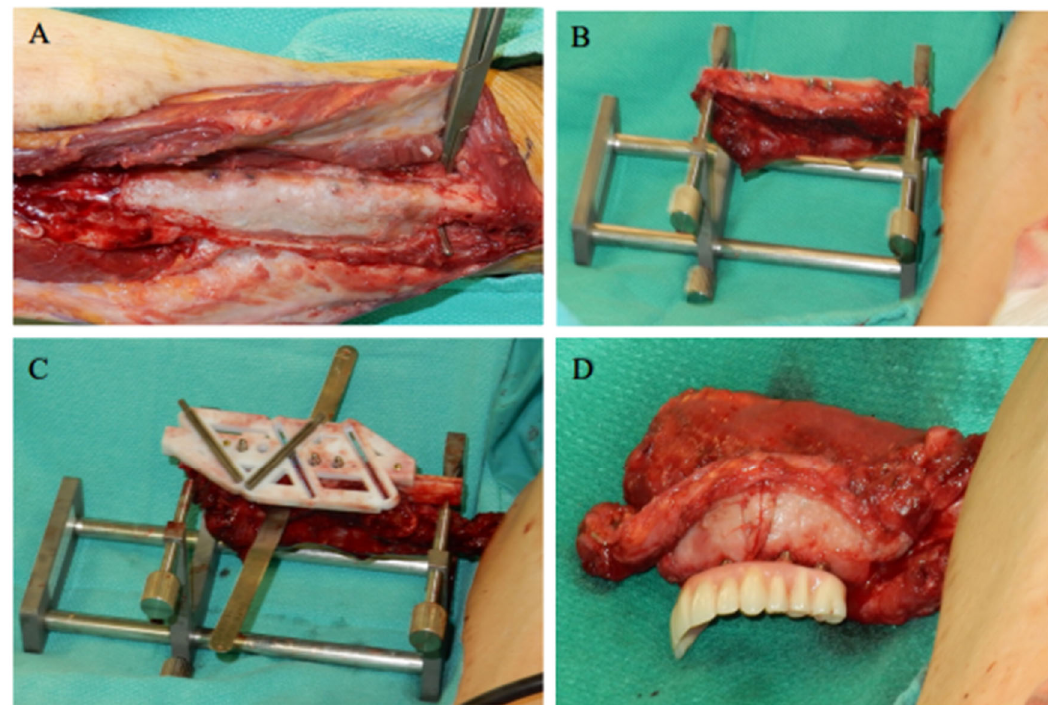
Figure 3. ( A ) Fibula was re ‐ exposed, and removal of the Gore ‐ Tex ® membrane revealed the newly